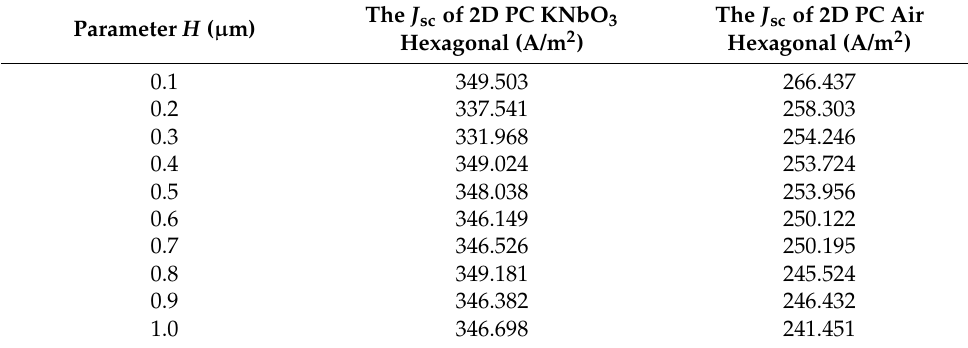
Table 5. The relationship of J sc on two different hexagonal scatterers and H .